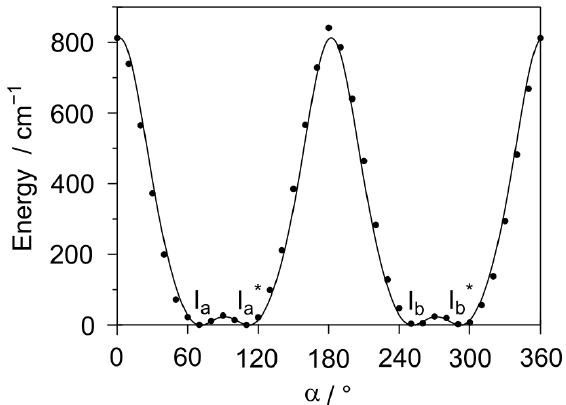
Figure 3. Potential energy curve of phenyl acetate obtained by varying the dihedral angle α = ∠ (C 13 -O 12 -C 3 -C 2 ) in 10° steps. The two double minima correspond to the I a /I a * and I b /I b * pairs. The barrier to convert I a in I a* or I b in I b* is 20.65 cm − 1 ; that to convert I a in I b or I a* in I b* is 837.45 cm − 1 . The minima are at α = 70°, 110°, 250°, and 290° with an energy of E = − 458.9579885 E h . All other energy values are relative to this value.